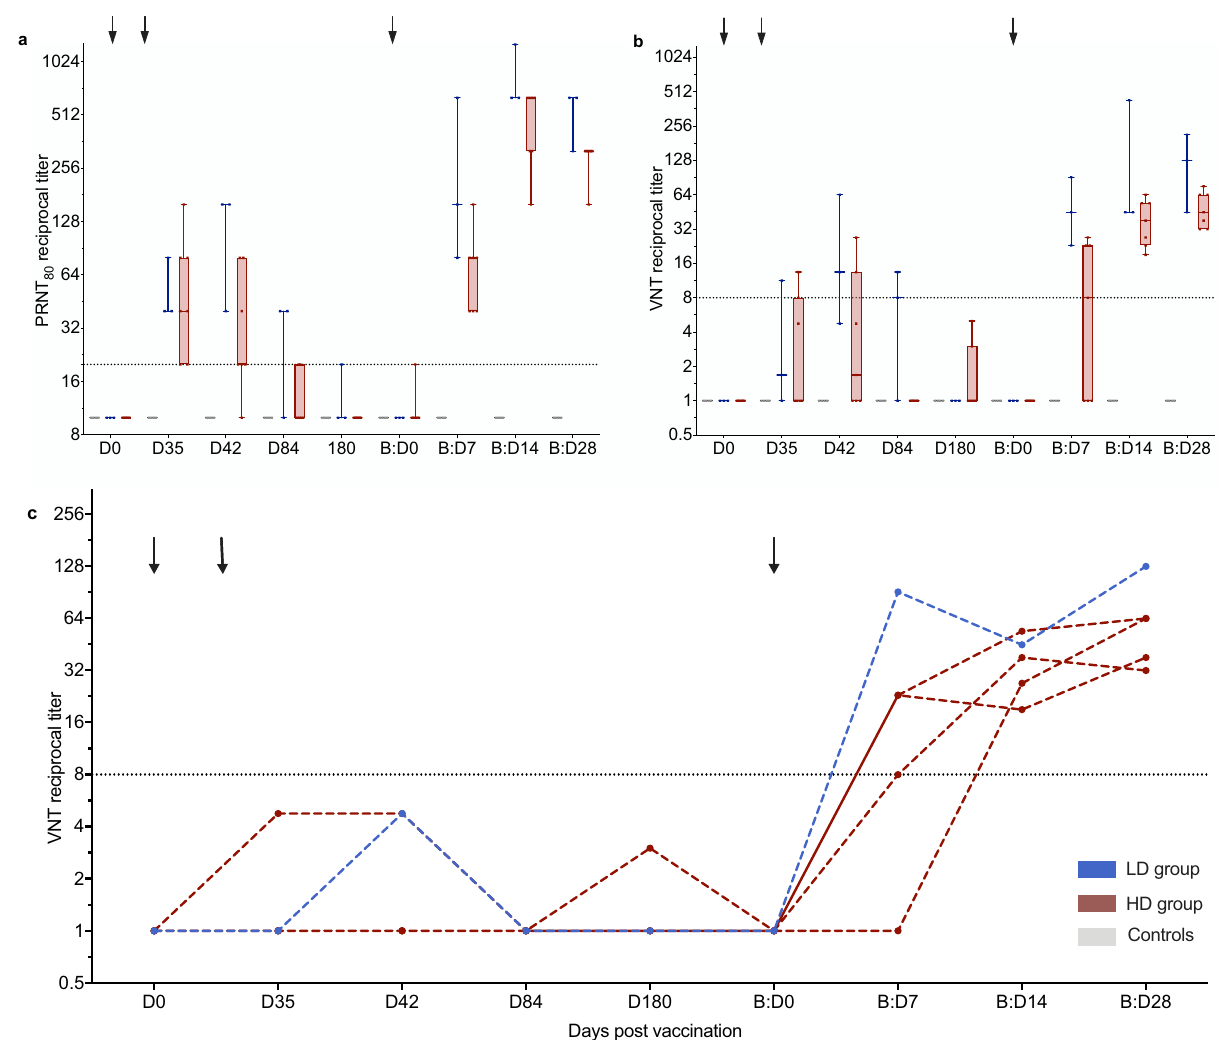
Fig. 4 Increase in MERS-CoV neutralizing antibodies after booster vaccination. MERS-CoV neutralization was measured by a ≥ 80% plaque reduction neutralization test (PRNT 80 ) and b , c virus neutralization test (VNT). Neutralizing antibody levels were measured in reciprocal titers ( y -axes) at multiple timepoints after fi rst (Day (D) 0 (D0), D35, D42, D84, and D180) and booster (B) (B:D0, B:D7, B:D14, and B:D28) vaccinations ( x -axes). Arrows indicate vaccinations. Horizontal dashed lines indicate the cut-off levels for positivity. a + b Boxes indicate 25 – 75 percentile; whiskers are min. to max.; medians are shown as horizonal lines within the boxes. Former low dose (LD, n = 3) and high dose (HD, n = 7) vaccinees are depicted in blue and red, respectively, controls in gray ( n = 4). c VNT titers after prime vaccination measured longitudinally in the fi ve individuals who did not develop nAb after prime vaccinations. Source data are provided as a Source Data fi